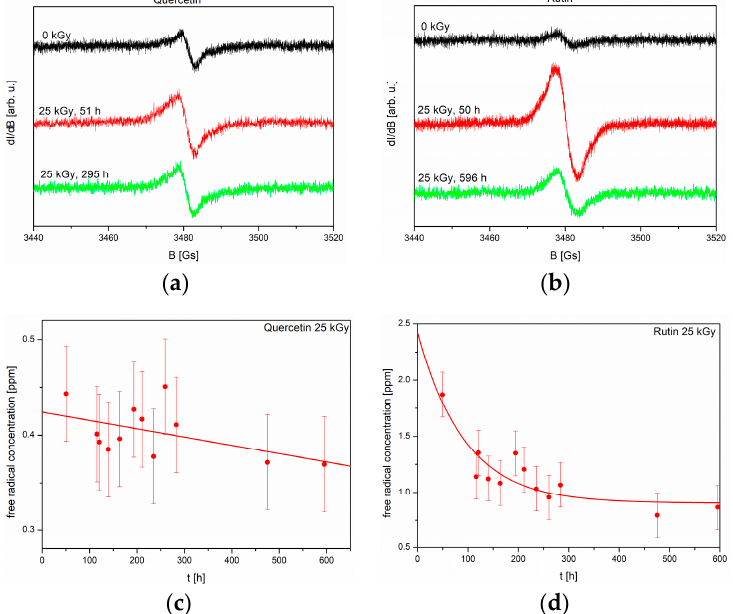
Figure 1. EPR spectra of non-irradiated (0 kGy) and irradiated (dose 25 kGy) samples recorded 51 and 595 h (quercetin) ( a ); 50 and 596 h (rutin) ( b ) after irradiation. The concentration of free radicals vs. time after irradiation (25 kGy) calculated from EPR spectra for quercetin ( c ) and rutin ( d ), respectively. The solid lines in ( c , d ) are the approximations of Equation (2) to the experimental points.